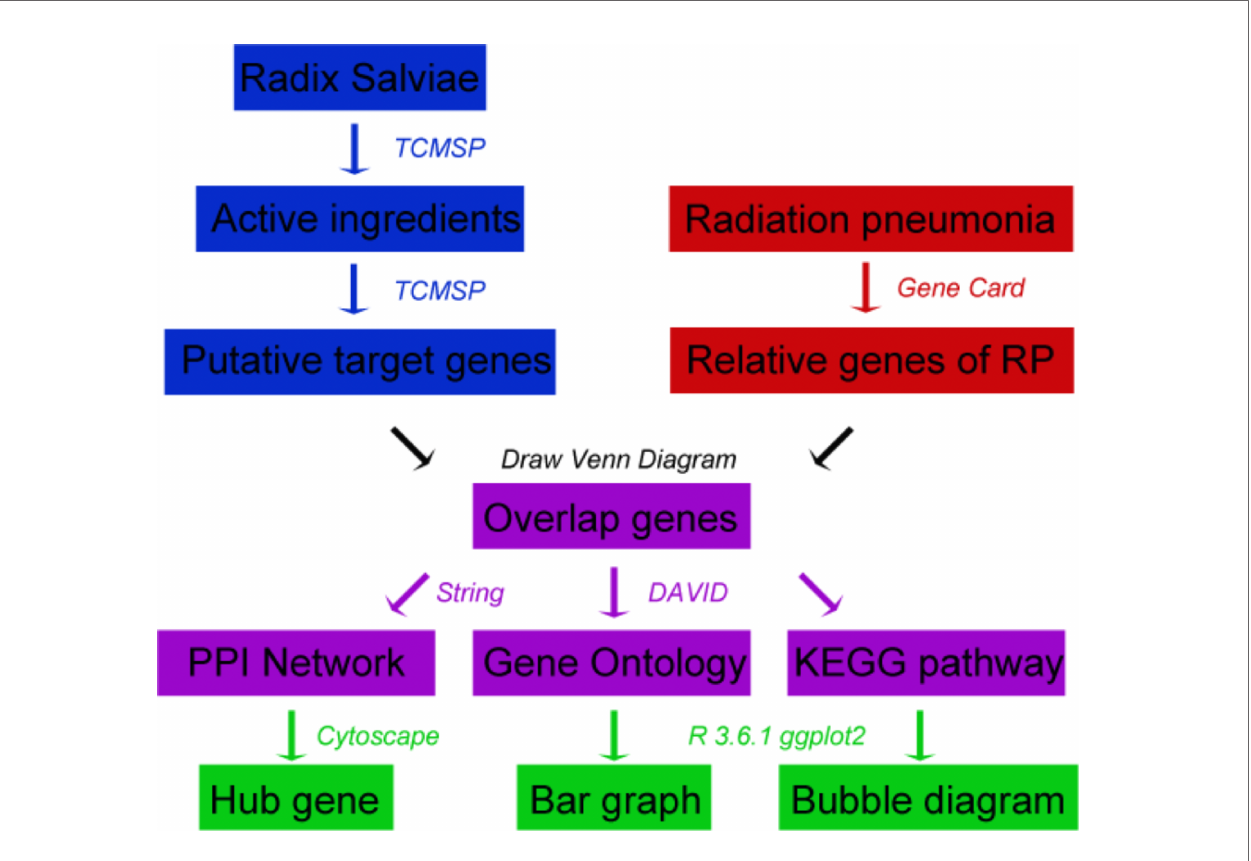
FIGURE 1 | Flowchart of the main research